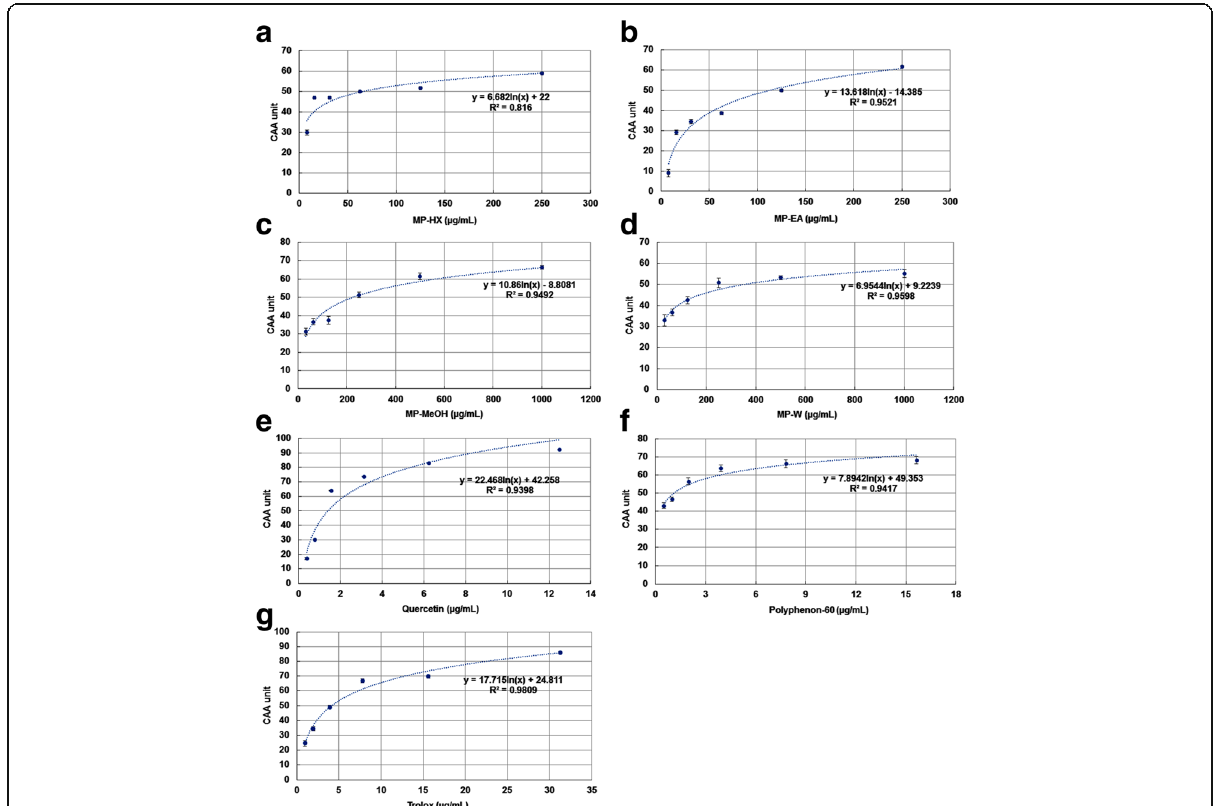
Fig. 3 Dose-response curve for inhibition of peroxyl radical-induced DCFH 2 oxidation in Hs27 cells by MP leaf extracts and positive controls. a MP-HX, b MP-EA, c MP-MeOH, d MP-W, e Quercetin, f Polyphenon-60 and g Trolox. The curves shown in each graph are from a single experiment (mean ± SD, n = 3)